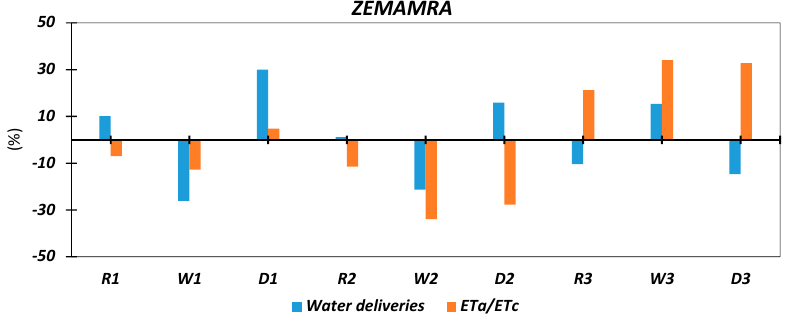
Figure 10. Sidi Bennour district; relative anomalies in quarterly water delivery W d and relative evapotranspiration (ET a /ET c ); 1,2,3 and R, W, D: see Figure 6.